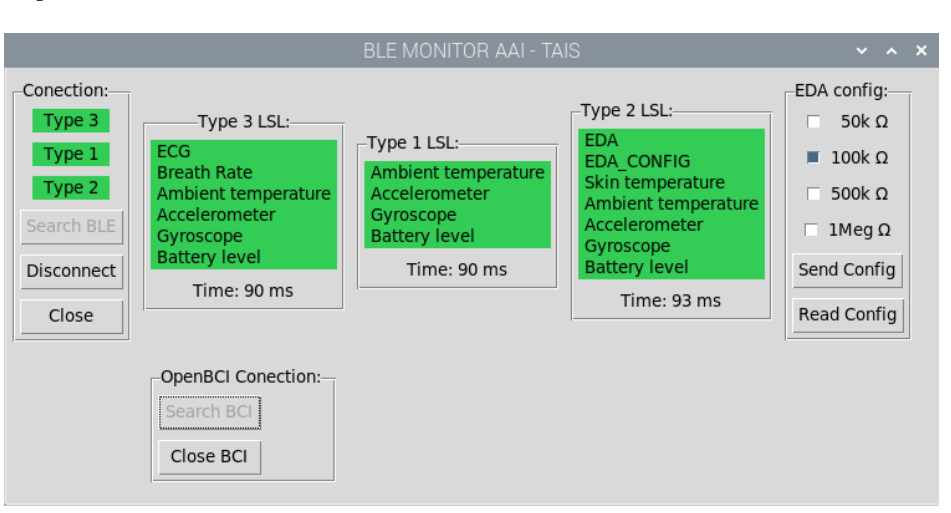
Figure 7. Application grafical user interface (GUI) developed to manage communication with the wearables. The process consists of: searching for the devices, setting and starting to send data. The color indicates the status: red means device not found, cyan indicates device found, and green indicates that data is being